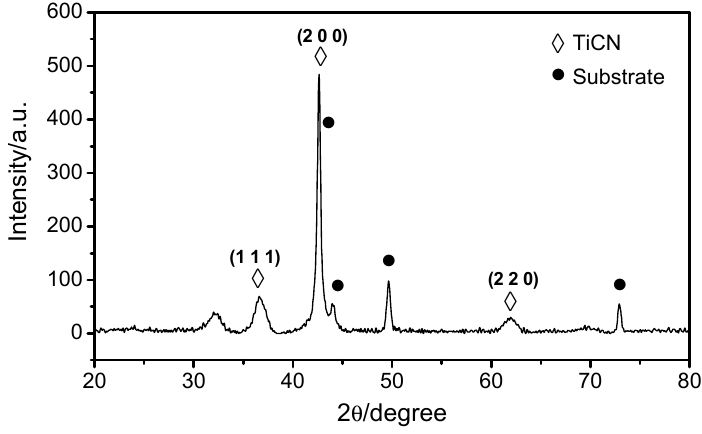
Figure 4. XRD patterns of the TiCN coating.